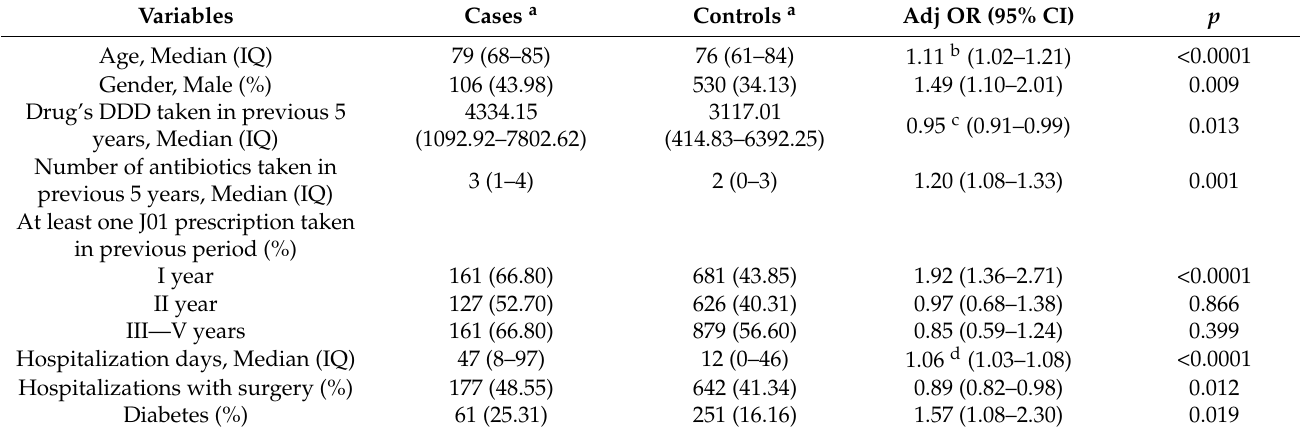
Table 2. Summarized results of the main multivariate analysis (backward step-wise